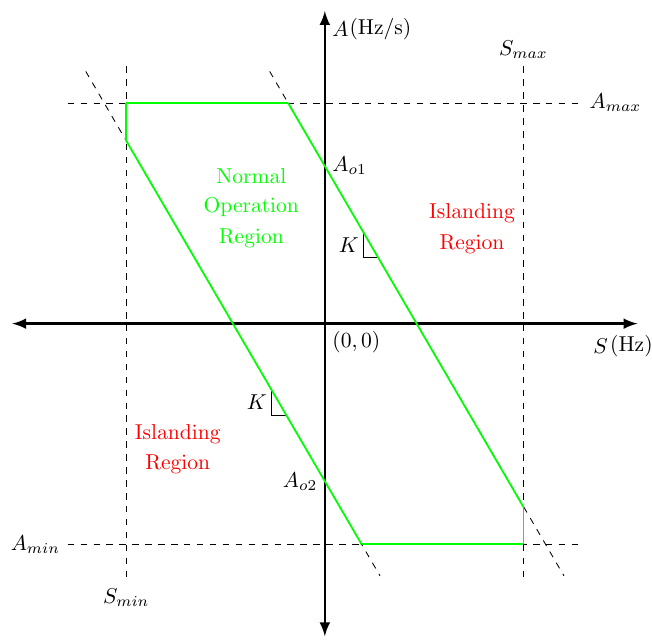
Figure 2. Modified OOST (MOOST) characteristic in the A − S